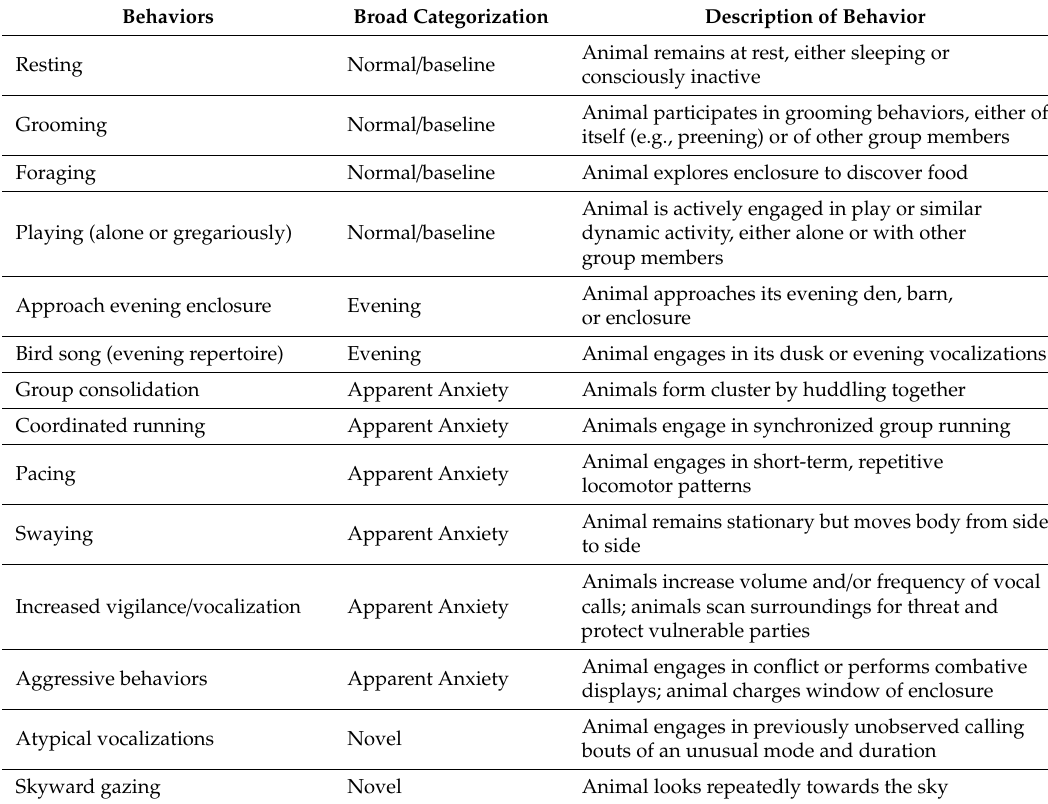
Table 1. Ethogram defining potential behavioral responses to the eclipse, and their associated